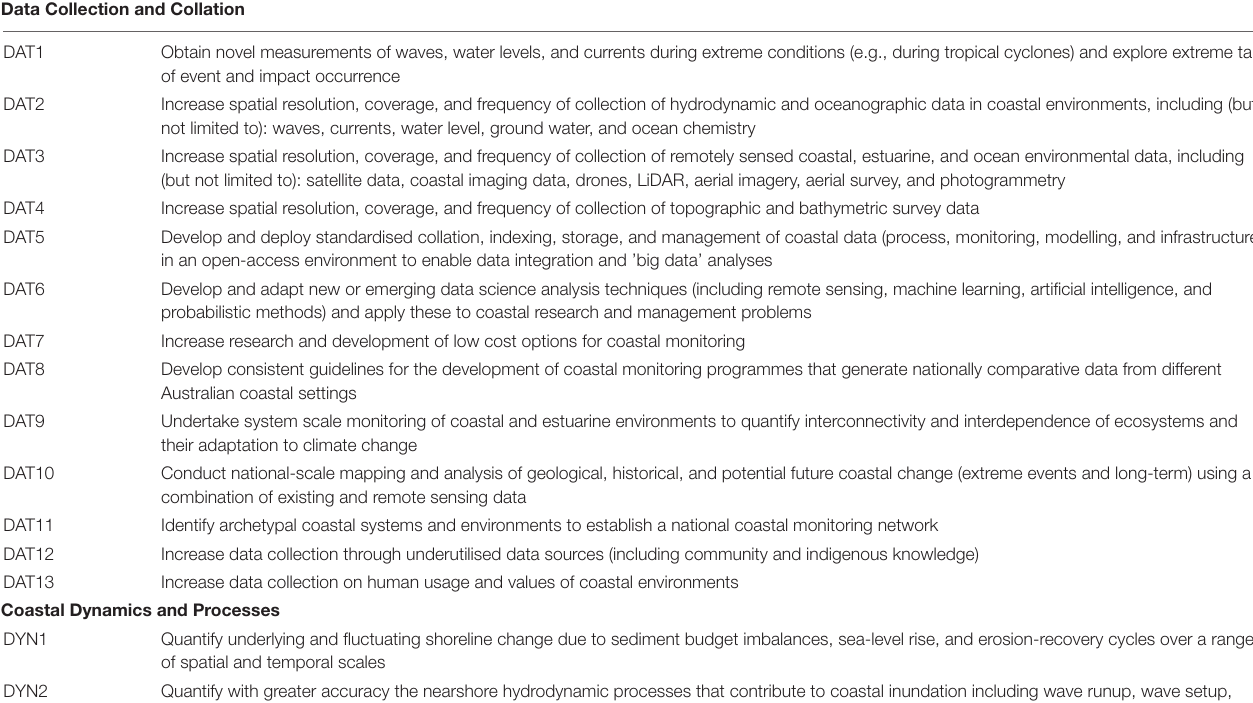
TABLE 1 | The priority research and enabling activities ( n = 74) synthesised from the 705 research activities and 192 infrastructure and equipment priorities that were nominated by respondents from the CGE research and stakeholder community ( N = 161). Data Collection and Collation